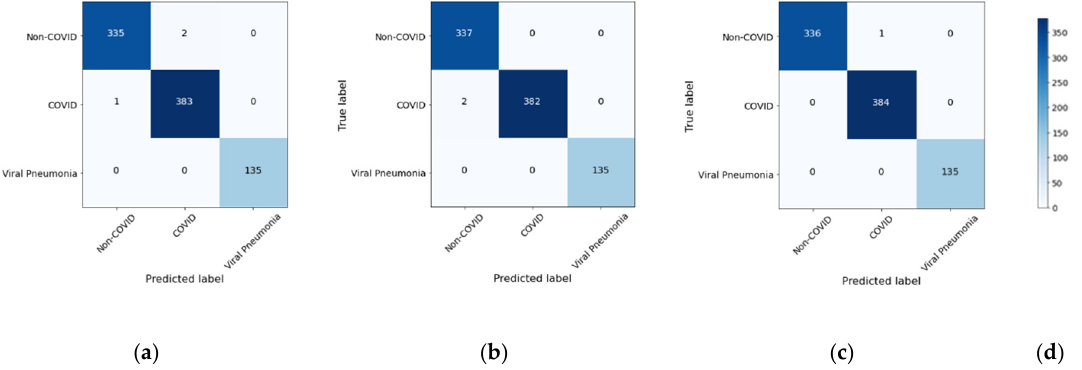
Figure 16. Confusion Matrix for Deep Meta-Learning Ensemble CNN Models ( a ) NN, ( b ) FCN, ( c ) Attentive Ensemble CNN Model, ( d ) label.